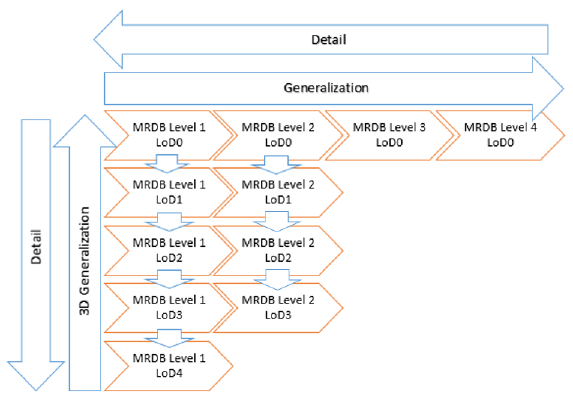
Figure 5. MRDB levels and LoDs for